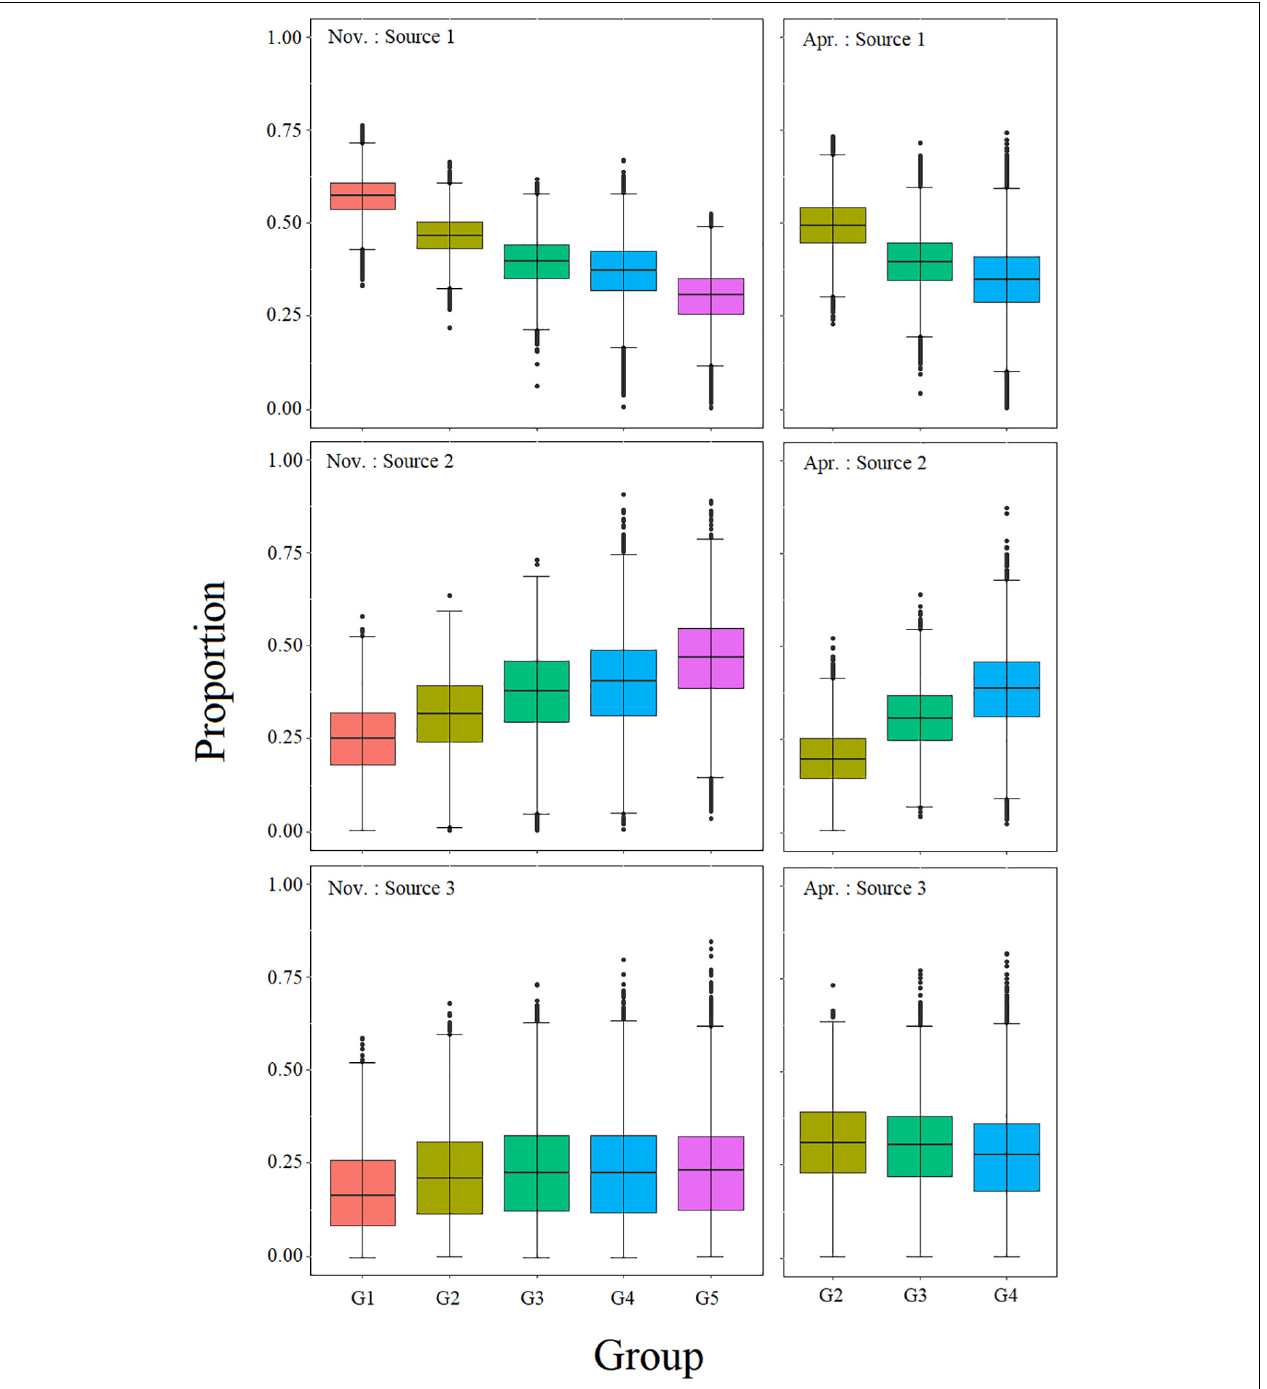
FIGURE 6 | Potential contribution of each resource to the diet of BD in the different body size groups. The different colors represent the different body size groups. The colored boxplots represent the 25th percentile, the median and the 75th percentile of the dietary proportions, while the whiskers represent the 1.5 × interquartile ranges (IQR) of the upper and lower quartile. Source 1: zooplankton, Source 2: Fish, Source 3: Shrimp and cephalopod.